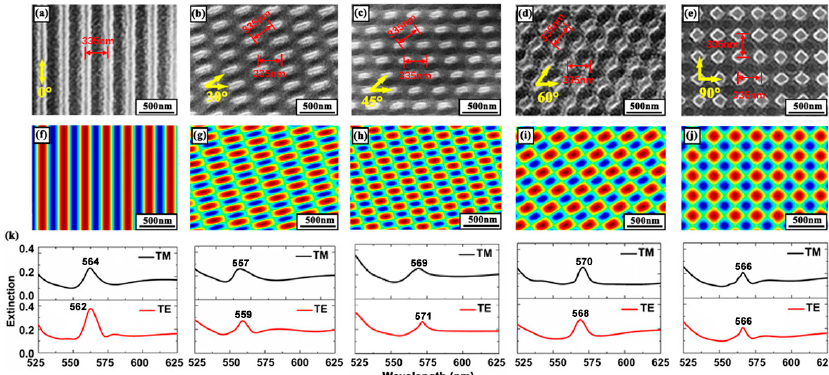
Figure 1. SEM images of ( a ) a 1D distributed feedback (DFB) grating and ( b – e ) 2D DFB gratings. The period is 335 nm. ( f – j ) Simulations of the interference pattern. ( k ) The transverse magnetic and transverse electric waveguide modes of di ff erent DFB